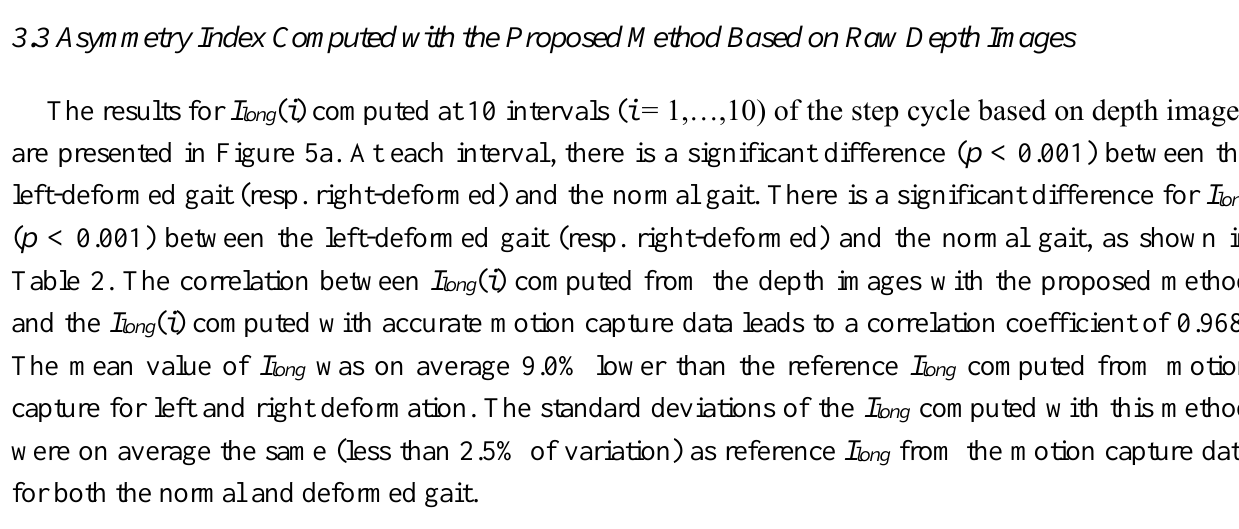
Table 2. The correlation between I long ( i ) computed from the depth images with the proposed method and the I long ( i ) computed with accurate motion capture data leads to a correlation coefficient of 0.968. The mean value of I long was on average 9.0% lower than the reference I long computed from motion capture for left and right deformation. The standard deviations of the I long computed with this method were on average the same (less than 2.5% of variation) as reference I long from the motion capture data for both the normal and deformed